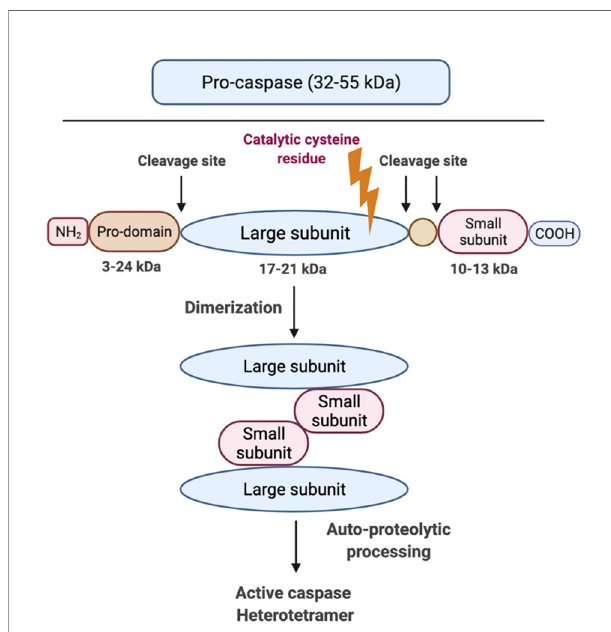
FIGURE 3 | Graphic representation of caspase structure. Caspases share a common structure, consisting of a 3-24 kDa NT pro-domain, a 17-21 kDa central large domain and a 10-13 kDa small CT subunit domain. All caspases consist of an active cysteine residue (bold lightning) in the large domain that speci fi cally cleaves after the aspartate residue in substrates. The activation of in fl ammatory caspases usually requires two steps: step 1 is dimerization that is induced by proximity and step 2 is auto-processing within the catalytic domain of each caspase